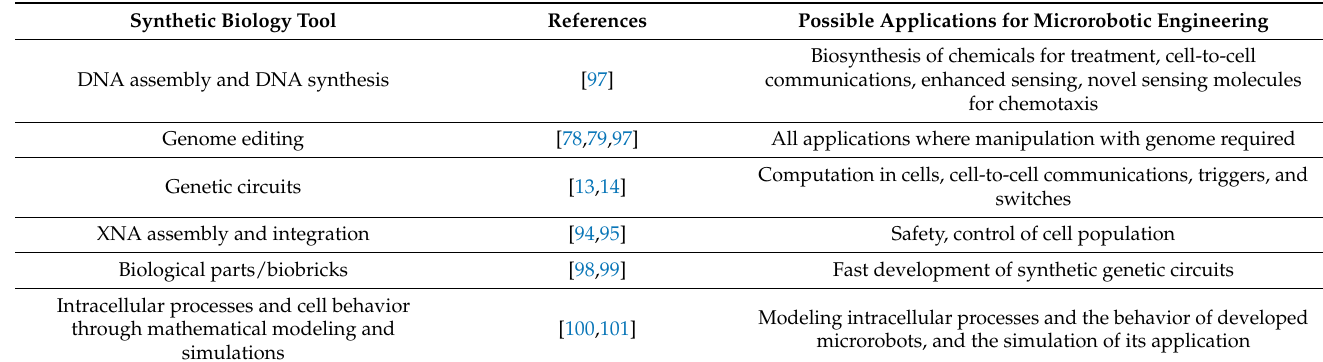
Table 3. Synthetic biology tools and prospective ways of their application in microbial cell-based microrobotic engineering and